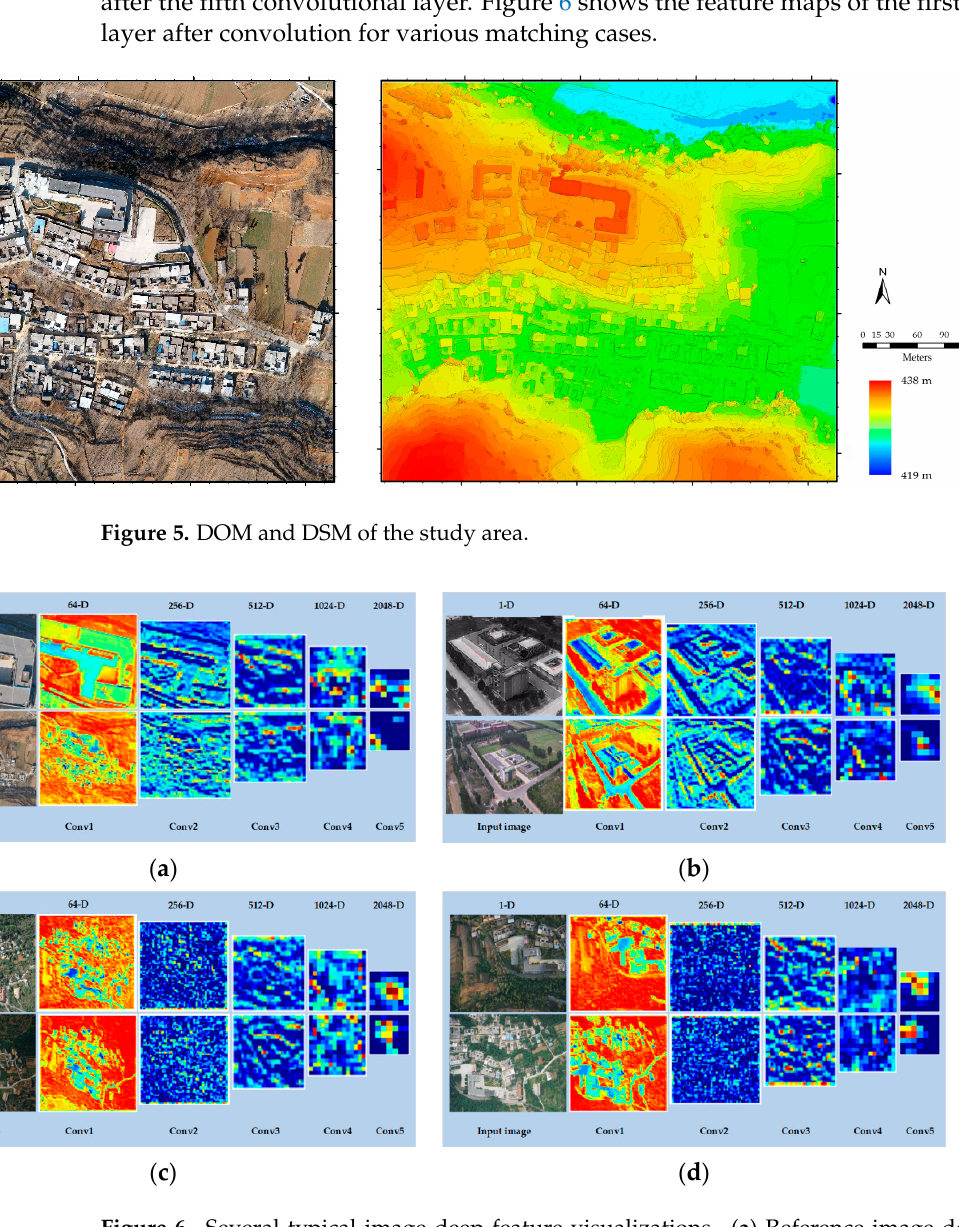
Figure 6. Several typical image deep feature visualizations. ( a ) Reference image deep features; ( b ) Heterogeneous image deep features; ( c ) Deep features of images varying in lighting; ( d ) Deep features of images varying in scale and season.